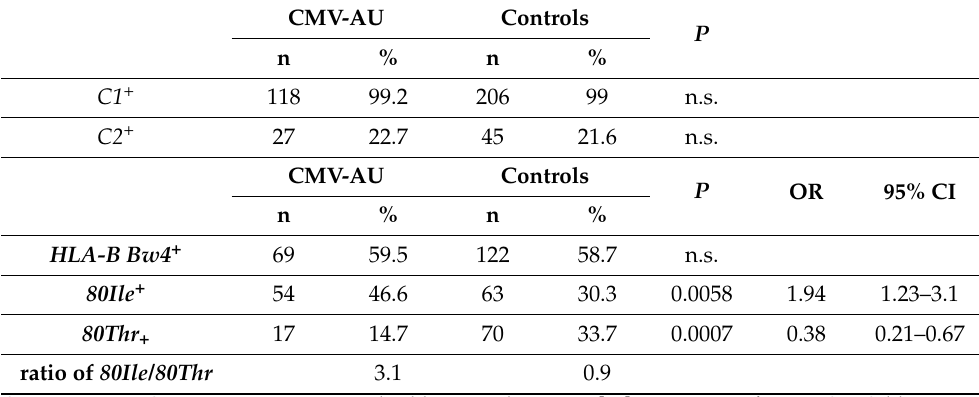
Table 2. Frequency of KIR ligands in CMV-AU and healthy controls.